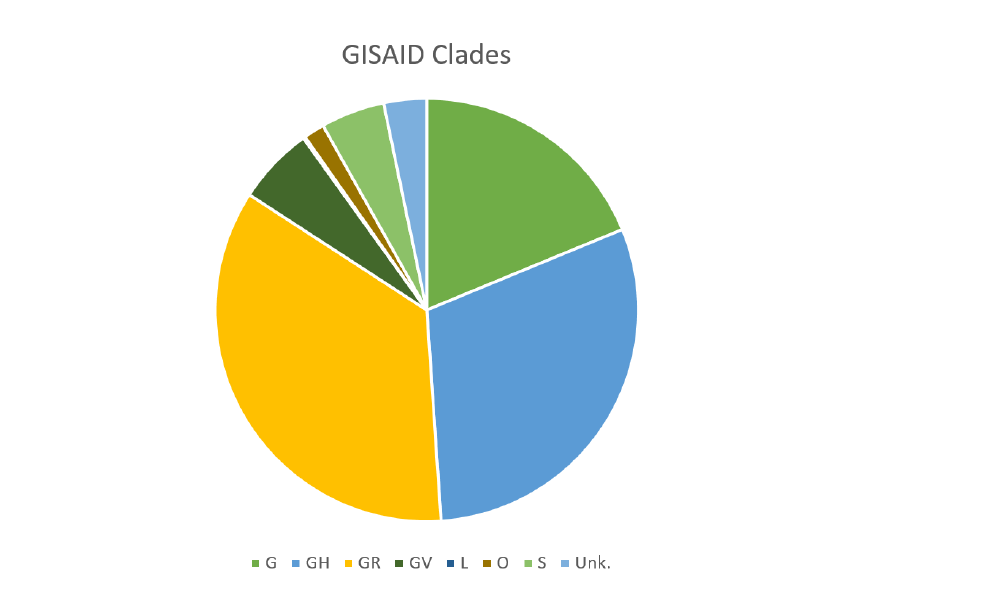
Table 5. Summary of mismatches between publicly available RT-PCR primers/probes and SARS-CoV-2 genomes analyzed in this study.